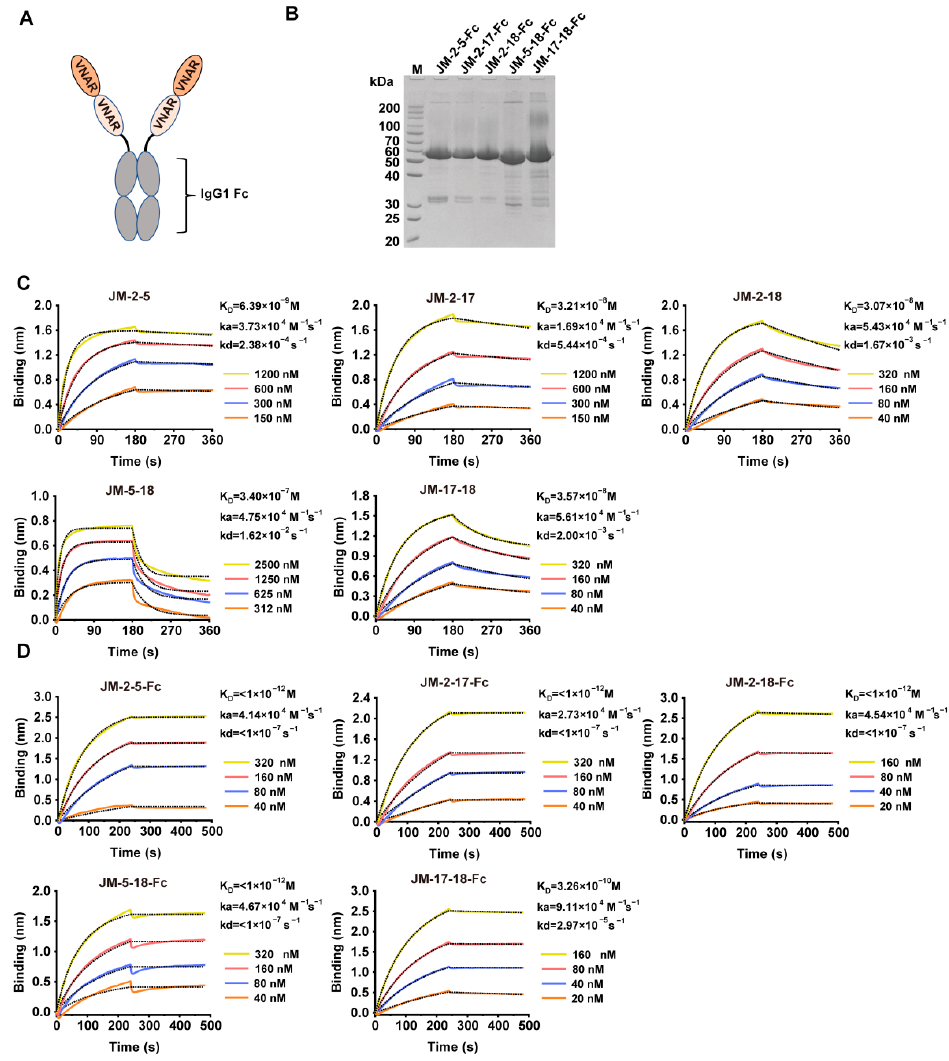
Figure 9. Preparation and characterization of bi-paratopic VNARs. ( A ) Scheme of bi-paratopic VNAR-Fc fusions. ( B ) SDS-PAGE analysis of purified bi-paratopic VNAR-Fc fusions. ( C , D ) Binding affinity of the bi-paratopic VNARs ( C ) or VNAR-Fc fusions ( D ) for WT SARS-CoV-2 RBD using BLI. The actual responses (colored lines) and the data fitted to a 1:1 binding model (black dotted lines) are shown. ka and kd represent the association constant and dissociation constant, respectively. The equilibrium dissociation constant K D was calculated as kd/ka.